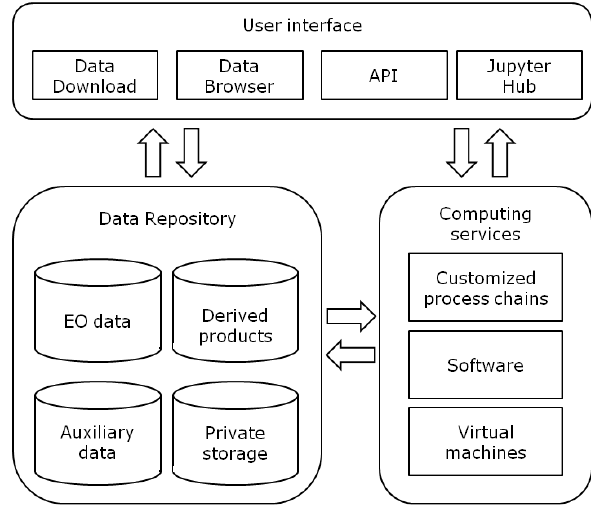
Figure 1. General scheme of a cloud service for InSAR processing. The presented cloud services vary mostly in the specification of the user interface and the availability of the computing